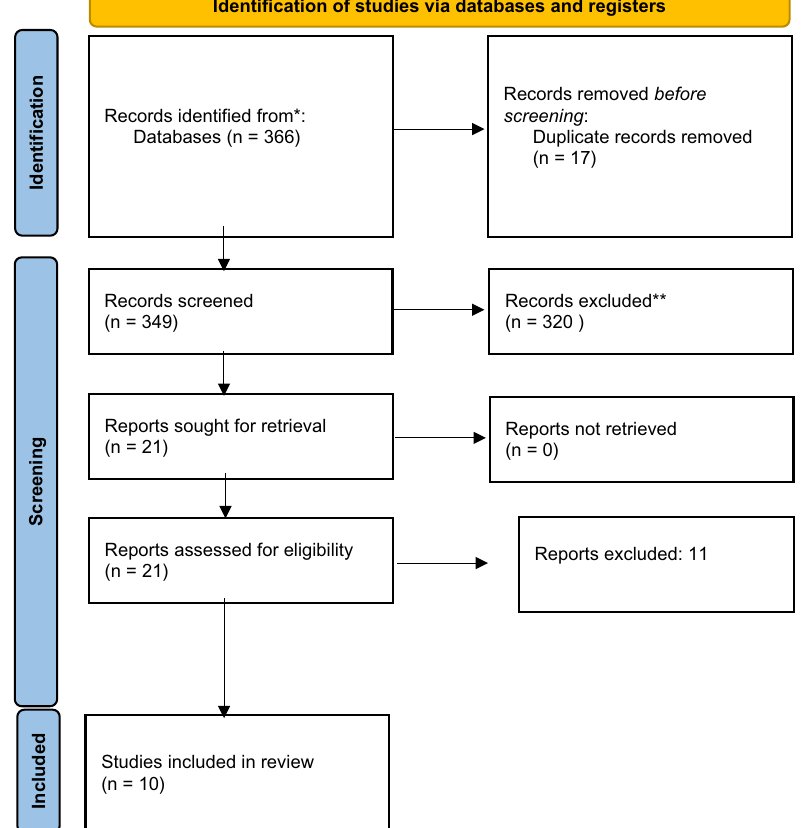
Figure 1. Flow diagram of study inclusion.